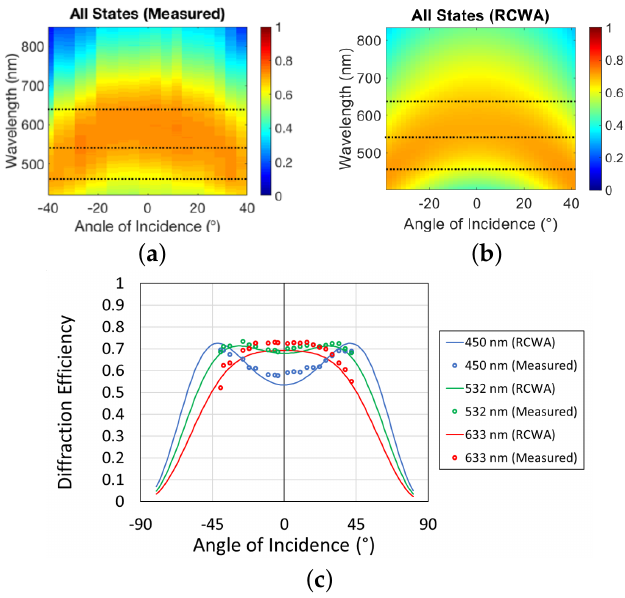
Figure 5. Diffraction efficiency for a blazed grating using all available phase levels. ( a ) Measured diffraction efficiencies for a 16-state blazed grating, ( b ) rigorous coupled wave analysis (RCWA) simulations (dashed lines correspond to common laser lines at 450 nm, 532 nm, and 632.8 nm), and ( c ) cross-sections of measured and simulated diffraction efficiencies for 450 nm, 532 nm, and 632.8